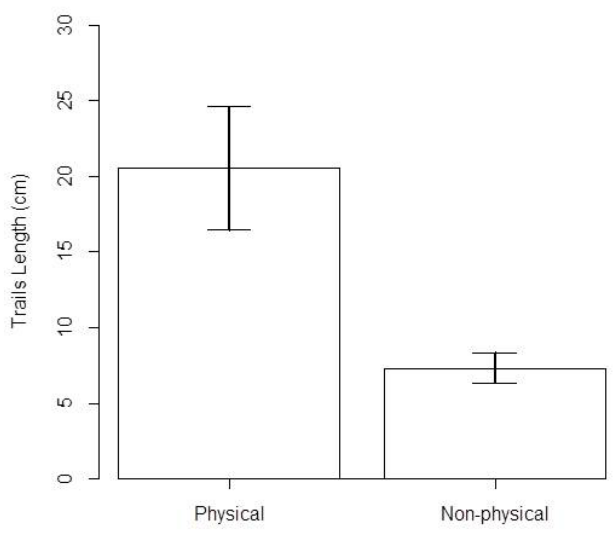
Fig 4A. Comparison of foraging trail features - physical and non- physical. A) Average and standard deviation of physical and non- physical trail